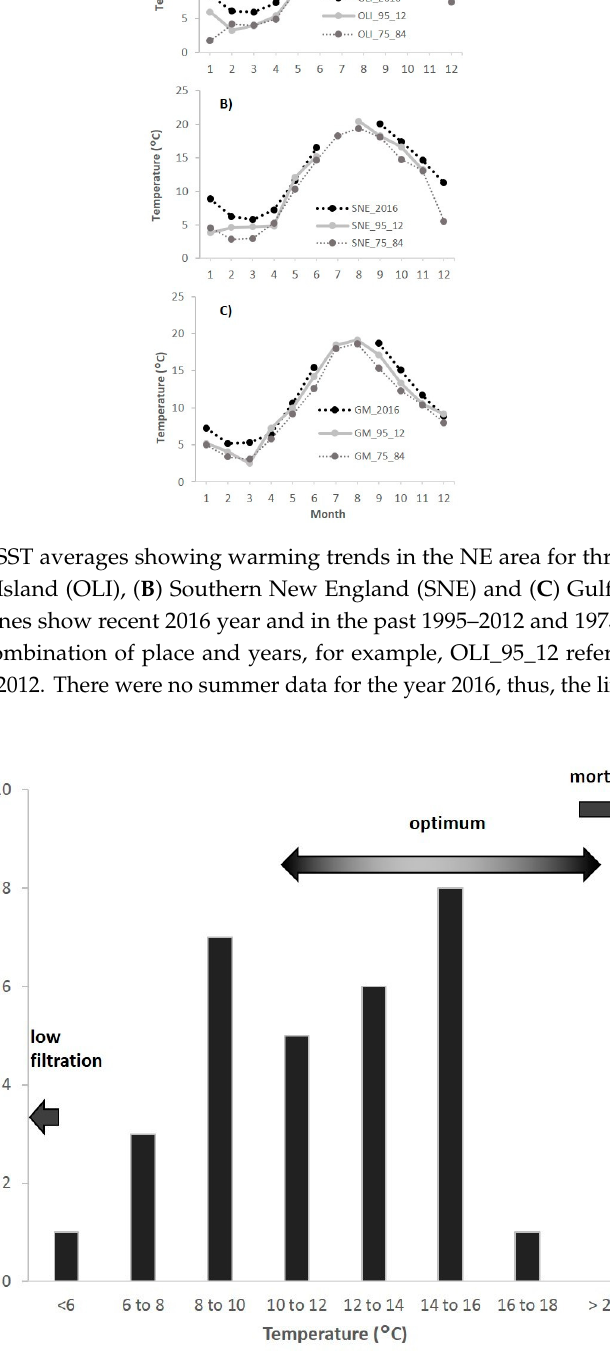
Figure 5. Monthly SST averages showing warming trends in the NE area for three different sectors: A ) Offshore Long Island (OLI), B ) Southern New England (SNE) and C ) Gulf of Maine (GM), in the last decades. Lines show recent 2016 year and in the past 1995–2012 and 1975–1984. The legend for each line is a combination of place and years, for example, OLI_95_12 refers to Offshore Long Island period 1995–2012. There were no summer data for the year 2016, thus, the lines for that year are not continuous.